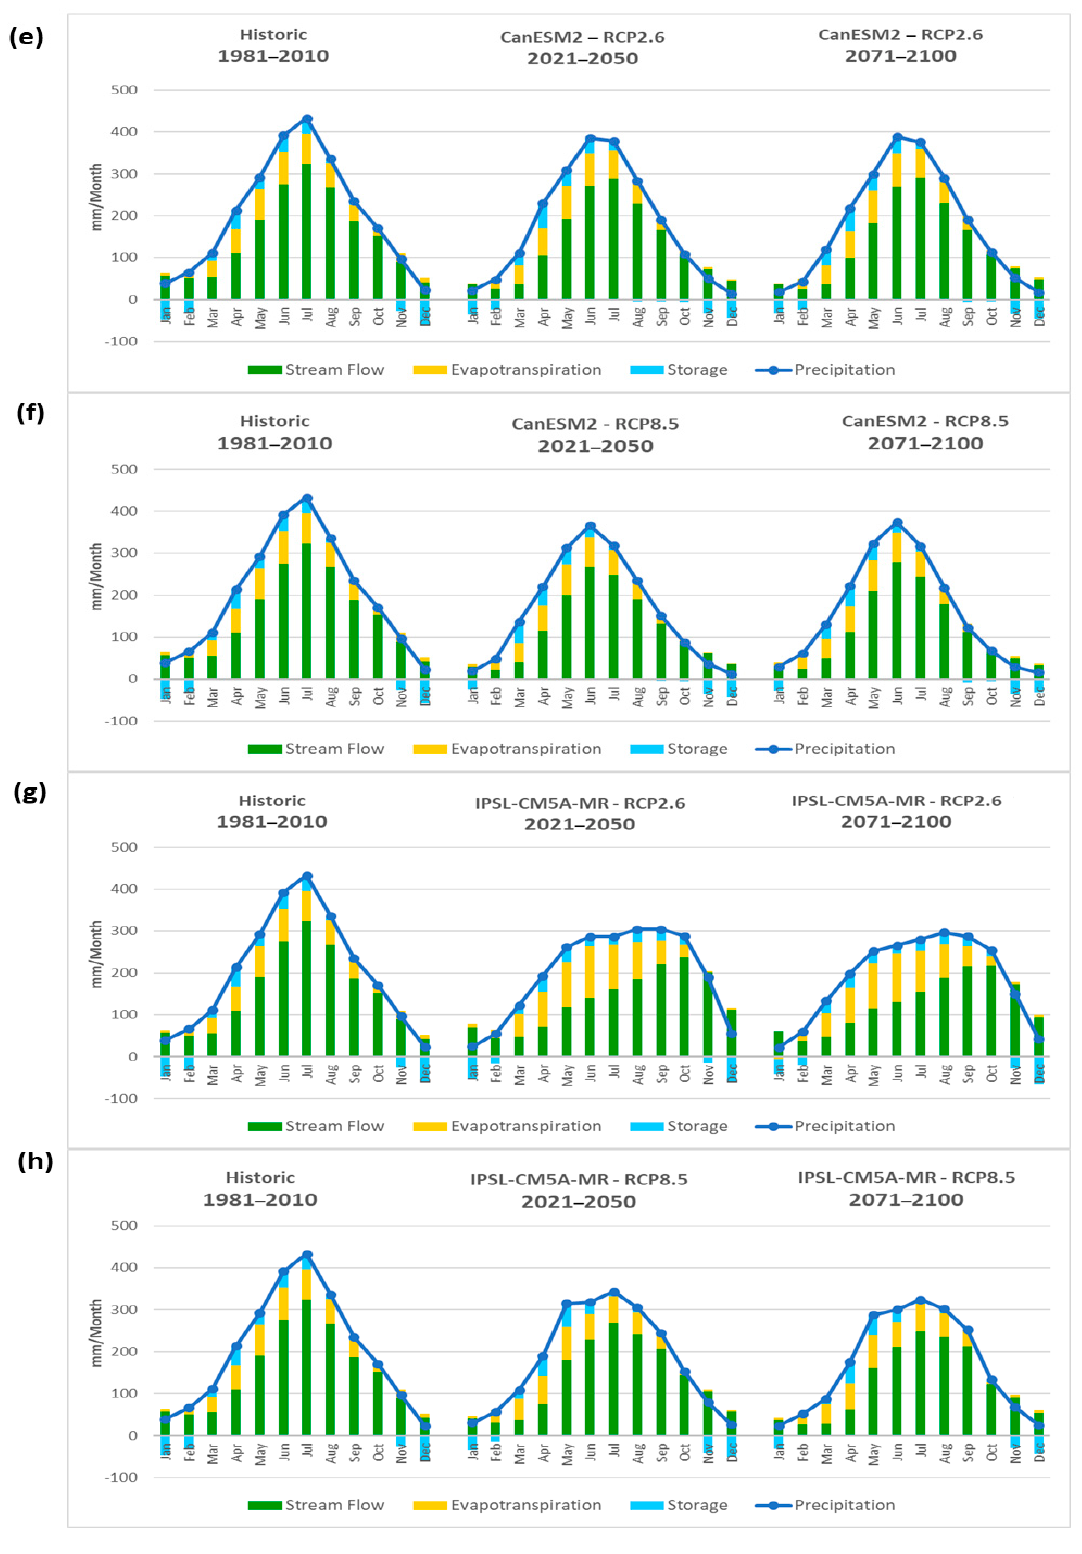
Figure A2. Bajo Figure A2. Bajo Meta